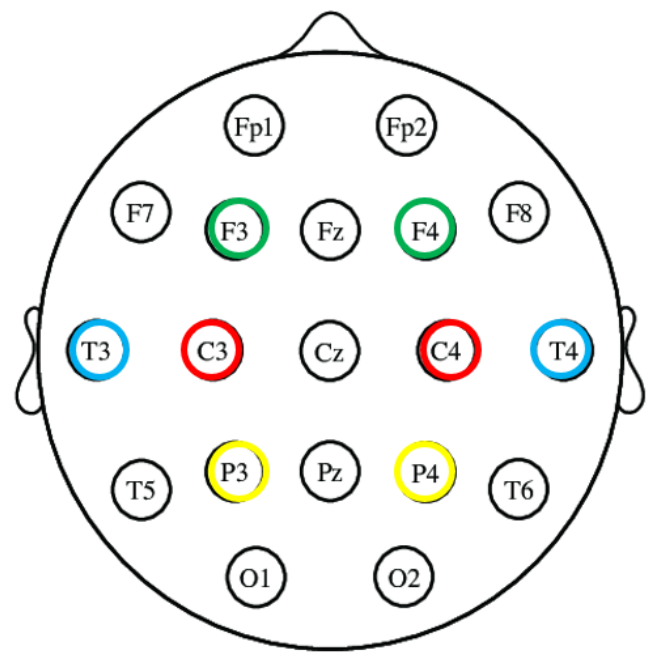
Figure 2. Electrode points of EEG recordings. EEG signals were recorded from ICU patients in fi ve stages, as seen in Figure 3, in- cluding three resting stages and nurse and family interaction (auditory, tactile stimuli) stages. During the fi rst stage of the recording process, EEG signals were obtained in a